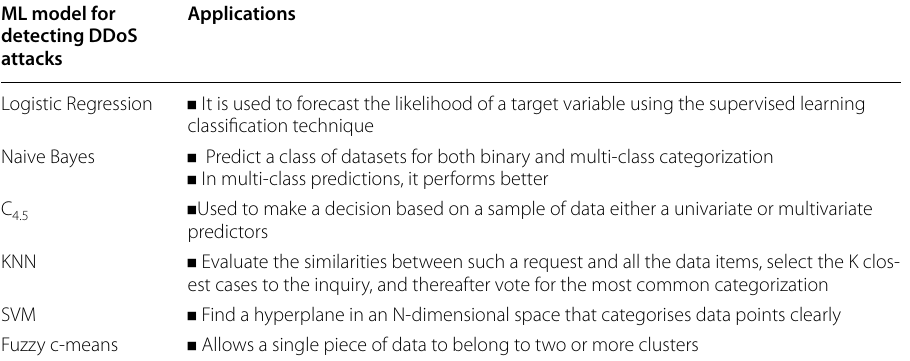
Table 3 Comparison overview of machine learning models with respect to DDoS detection ML model for detecting